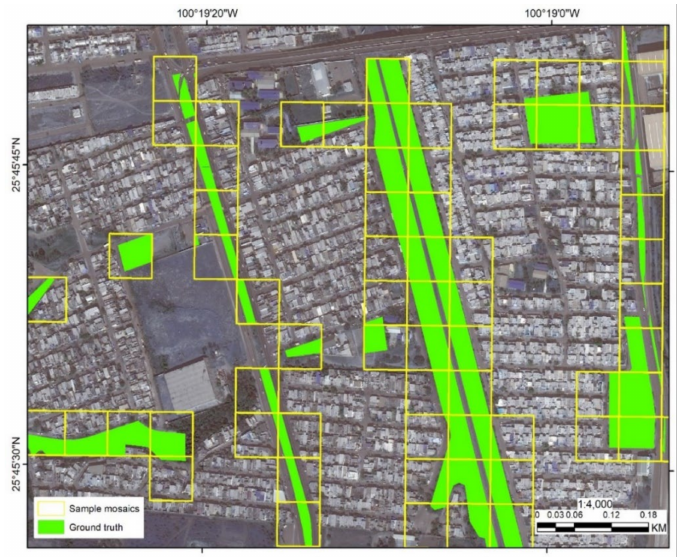
Figure 6. The ground truth coverage and the testing subset with 68 mosaics used to evaluate the CNN